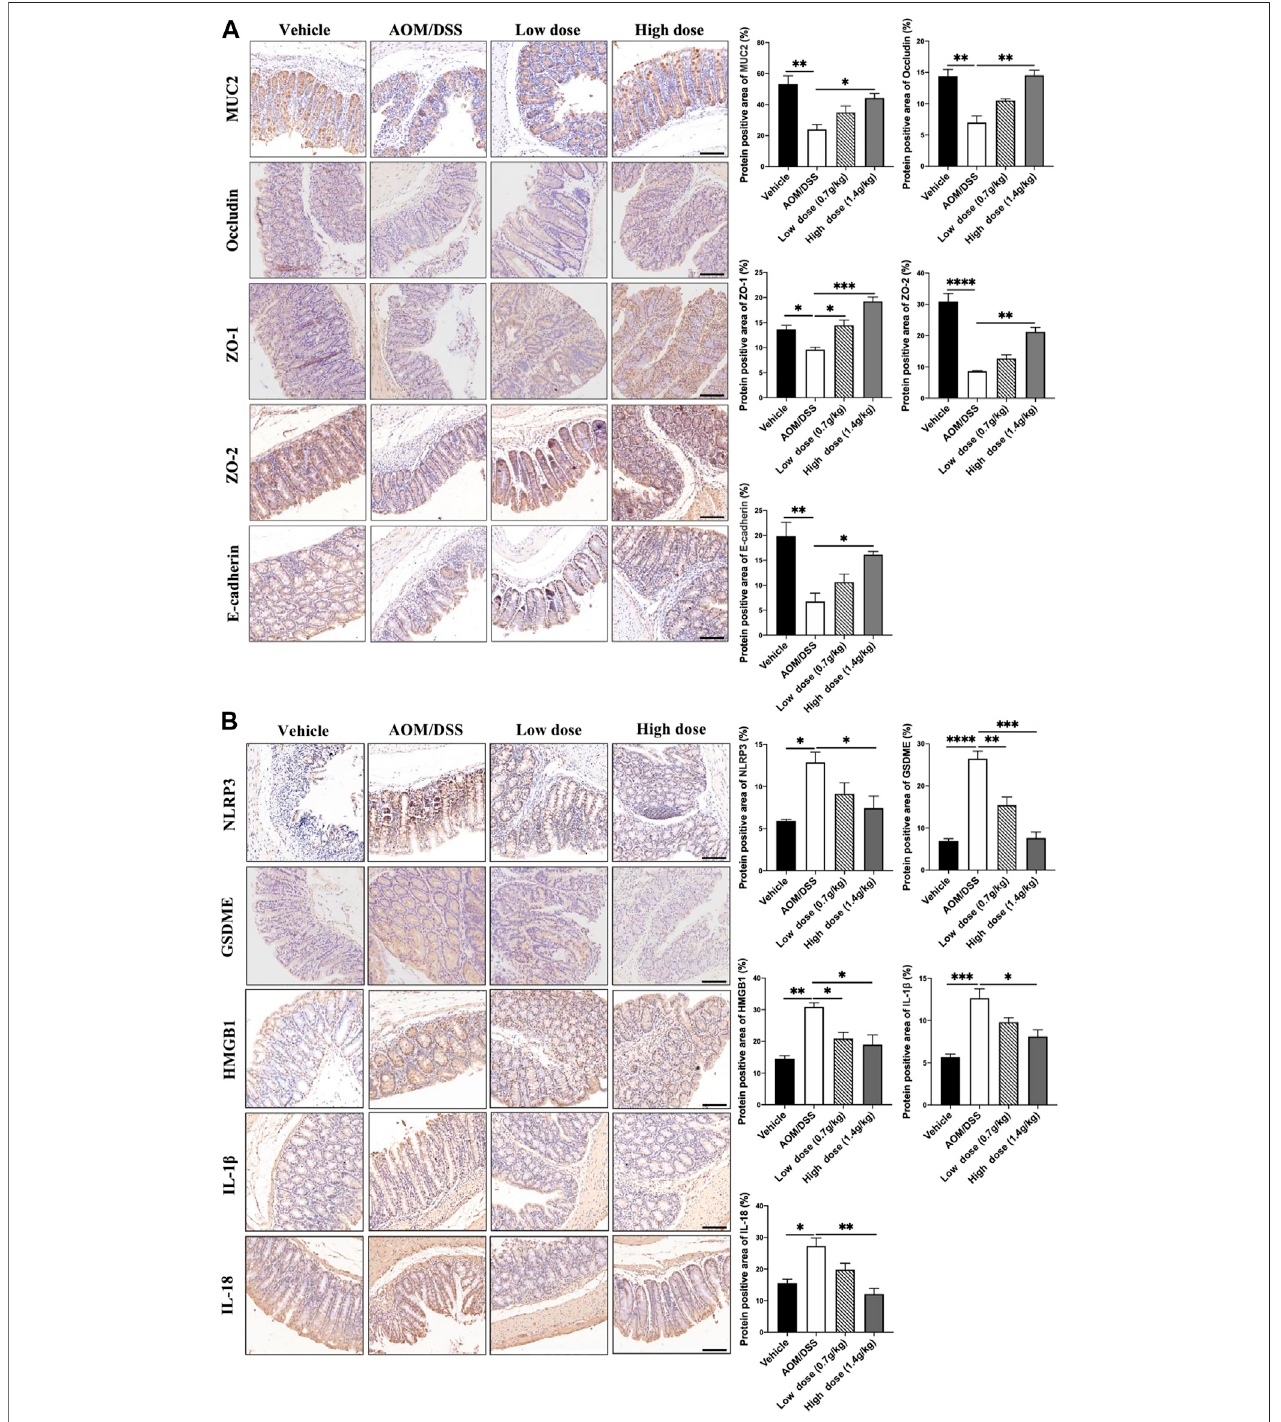
FIGURE 4 | Effects of QCWZD on the intestinal barrier and pyroptosis in AOM/DSS-treated mice. (A) Levels of MUC2, occludin, ZO-1, ZO-2, and E-cadherin in AOM/DSS-treated mice (magni fi cation: ×200). (B) Levels of NLRP3 , GSDME, HMGB1, IL-1 β , and IL-18 in AOM/DSS-treated mice (magni fi cation: ×200). Low dose: 0.7 g/kg, High dose: 1.4 g/kg * p < 0.05; ** p < 0.01; *** p < 0.001; **** p < 0.0001.